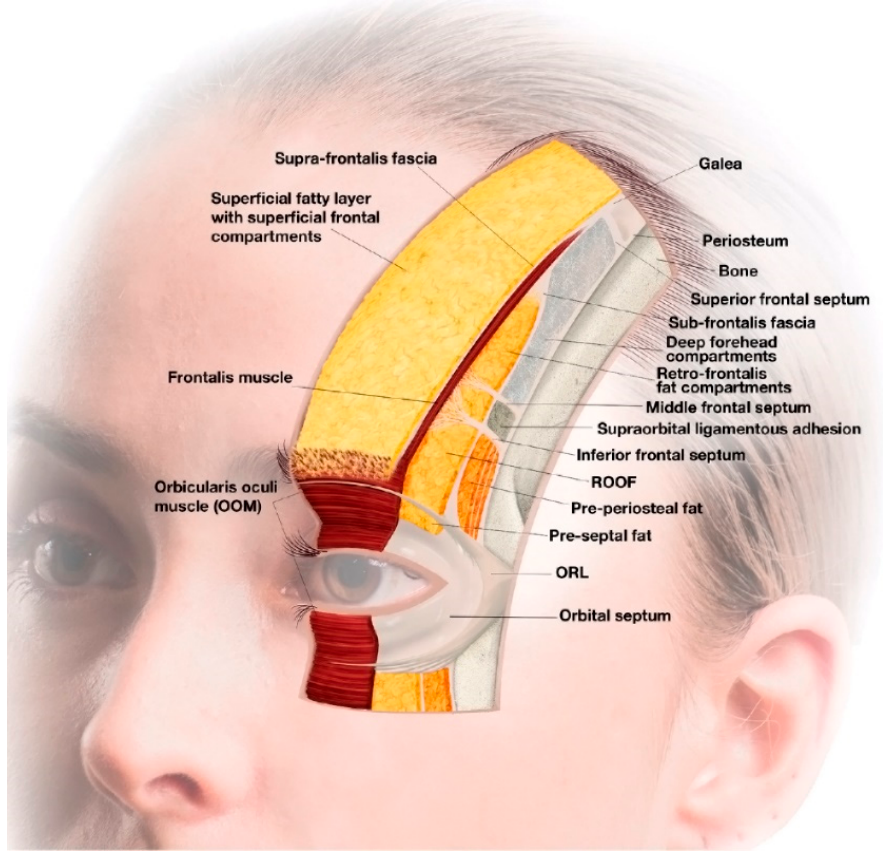
Figure 3. The eight-layer forehead configuration system. The fascial layers are exposed in a progressive fashion, beginning at the skin (medially) and progressing deeper till they reach the bone (laterally, temporal crest). The hue of the neighboring fat can also be used to determine the depth of each structure. The superficial fatty layer is the lightest (yellow), the retrofrontalis fat is slightly darker (bright orange), and the preperiosteal fat is the darkest (dark orange). Note how the orbicularis retaining ligament and the supraorbital ligamentous adhesion transition into more superficial layers and provide boundaries for cranial and caudal compartments [34].